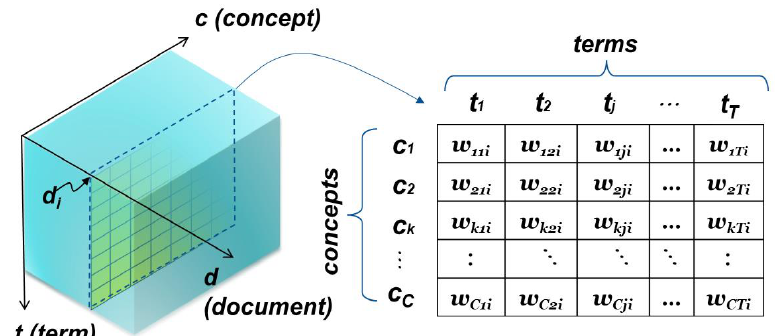
Figure 1. Our tensor space model for document